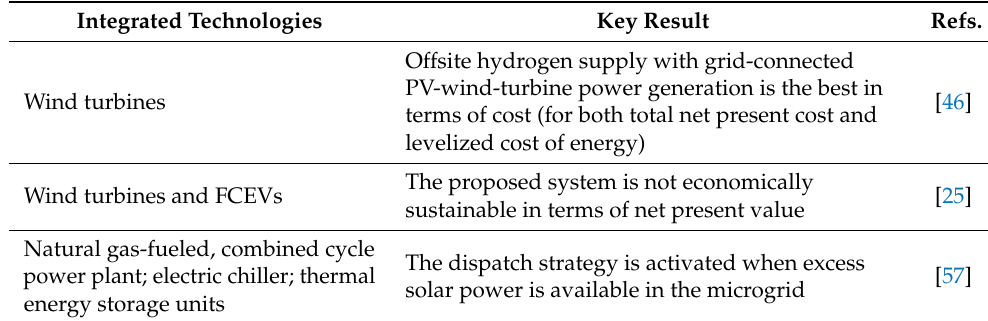
Figure 14. Schematic configuration of a hybrid PV-RHFC microgrid system coupled with a flywheel. Reprinted with permission from Ref. [20]. 2019, Elsevier. Table 5. Integration with other power generating and energy storage technologies.